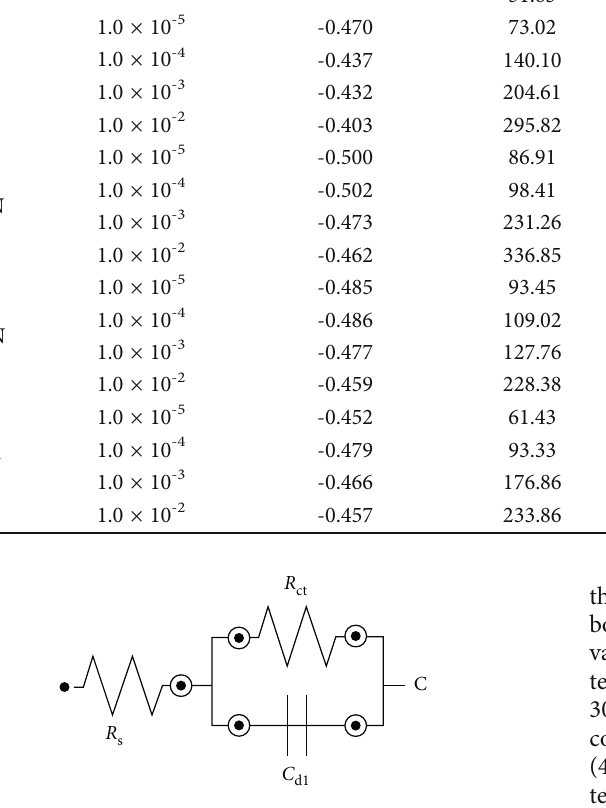
Figure 3: Equivalent circuit for the